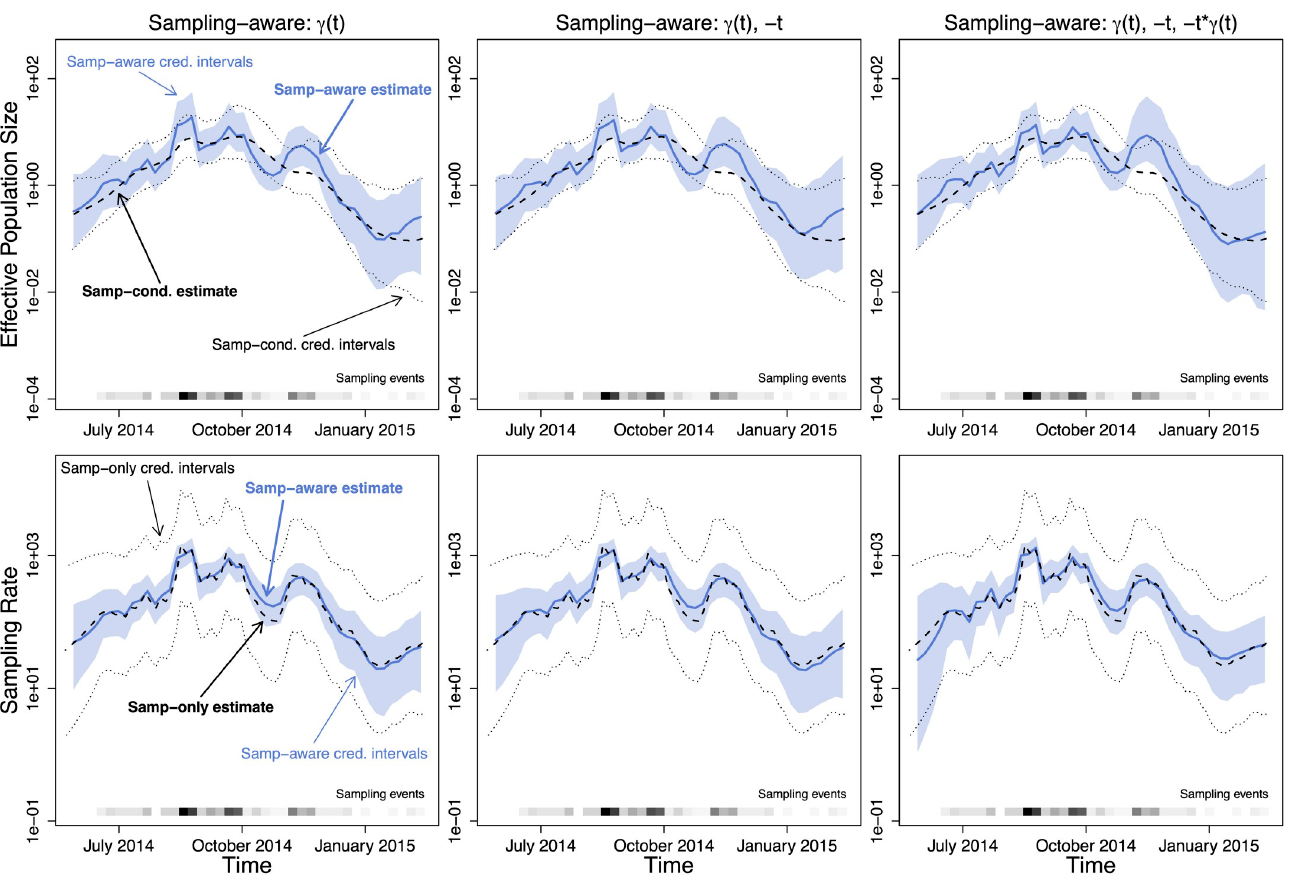
Fig 8. Effective population size and sampling rate reconstructions for the Liberia Ebola dataset. Upper row : Dashed lines and dotted black lines are the pointwise posterior effective population size estimates and credible intervals of the sampling-conditional model. The blue lines and the light blue regions are the pointwise posterior effective population size estimates and credible intervals of that column’s sampling-aware model. Lower row : Dashed lines and dotted black lines are the pointwise posterior sampling rate estimates and credible intervals of a nonparametric sampling-time-only model. The blue lines and the light blue regions are the pointwise posterior sampling rate estimates and credible intervals of that column’s sampling-aware model.